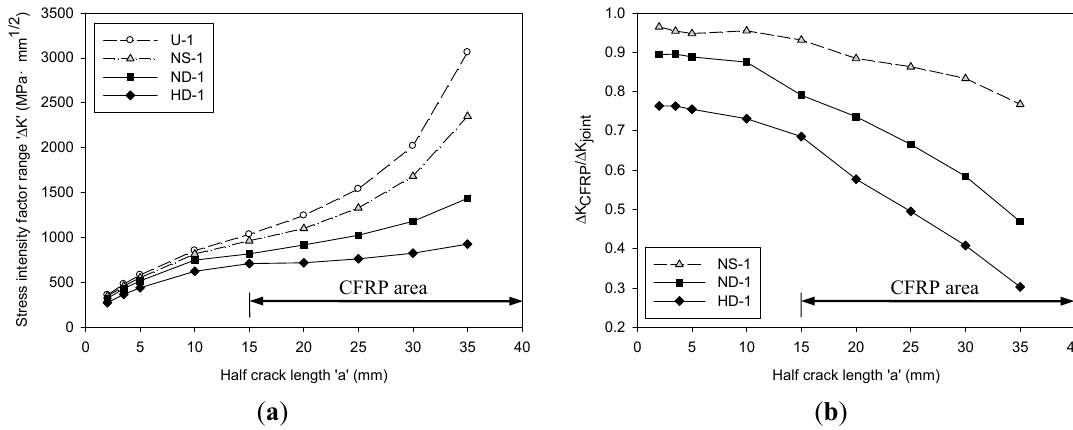
Figure 15. ( a ) Stress intensity factor; ( b ) Stress intensity factor ratio.